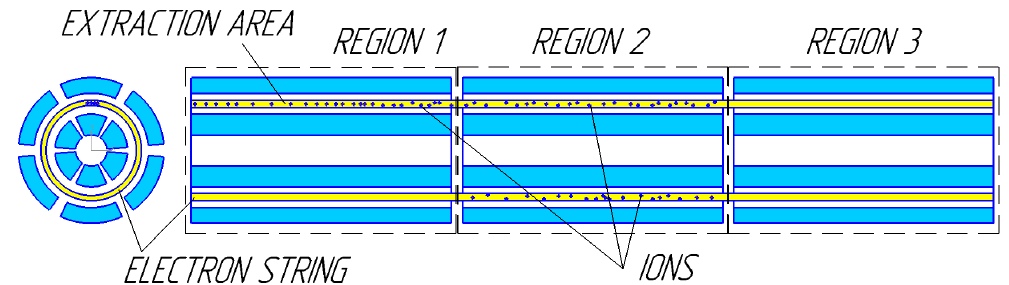
Figure 3. TESIS drift structure design. It can be divided into three regions: neutral atoms are injected and ionized in the second, then extracted through the first. In the third, potential barrier is formed to prevent ions escape the trap.